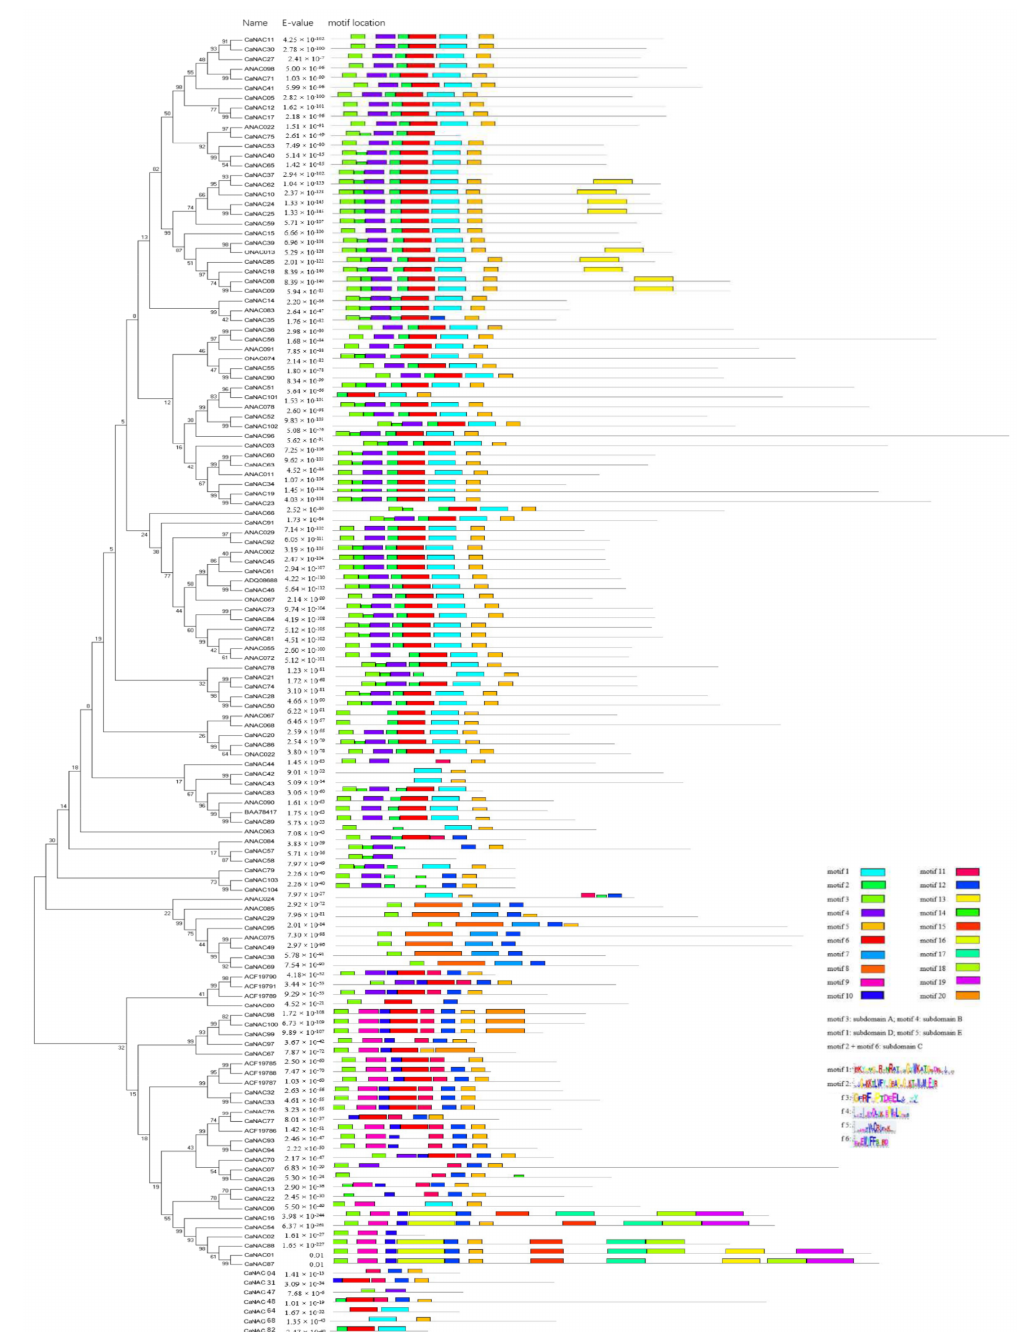
Figure 4. Alignment of multiple CaNAC and selected ONAC , ANAC domain amino acid sequences, schematic diagram of amino acid motifs of CaNAC and ONAC , ANAC protein groups or subgroups. Motif analysis was performed using Meme 4.12.0 online software (Available online: http://meme- suite.org/tools/meme) as described in the methods. The NAC proteins are listed on the left. The different-colored boxes represent different motifs and their position in each NAC sequence. The sequences of key motifs (motif 1, motif 2, motif 3, motif 4, motif 5, and motif 6) are shown on